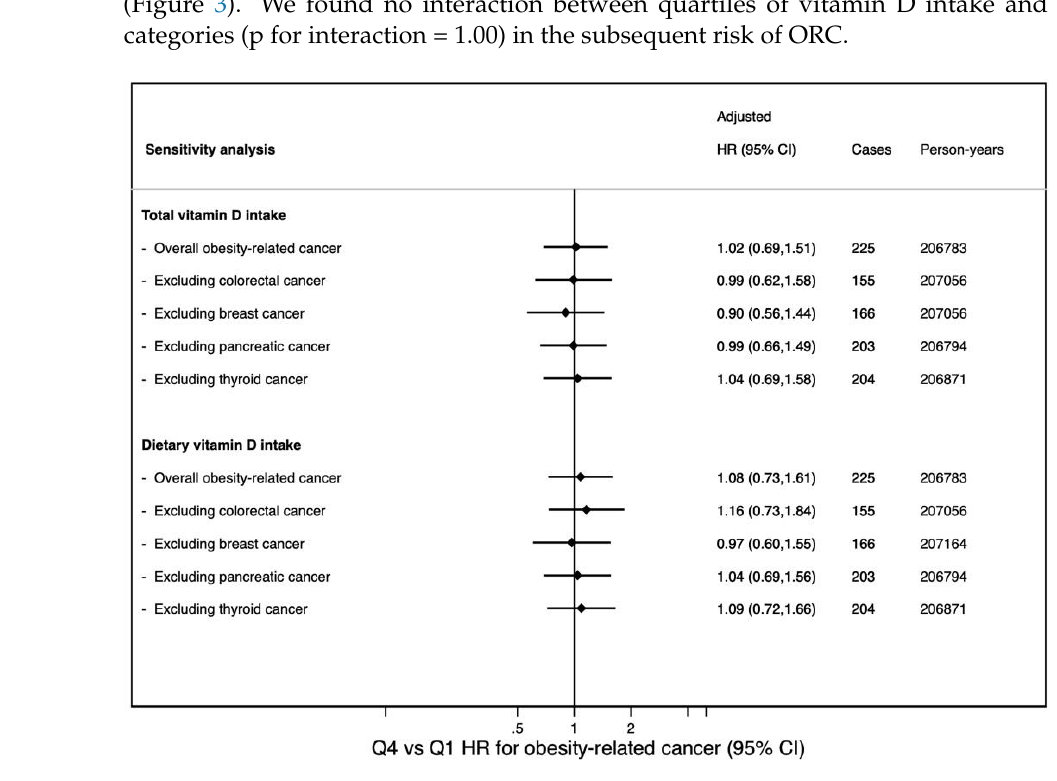
Figure 2. Hazard ratio (95% CI) for the comparison across extreme quartiles of overall obesity-related cancer and excluding tumors which accounted for at least 10% of cases.